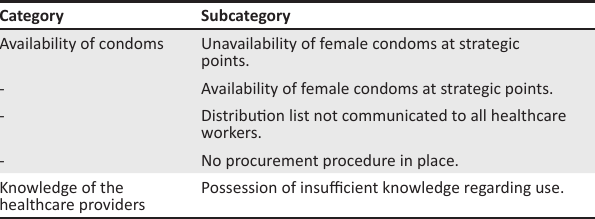
TABLE 1: Categories and subcategories. Category Subcategory Availability of condoms